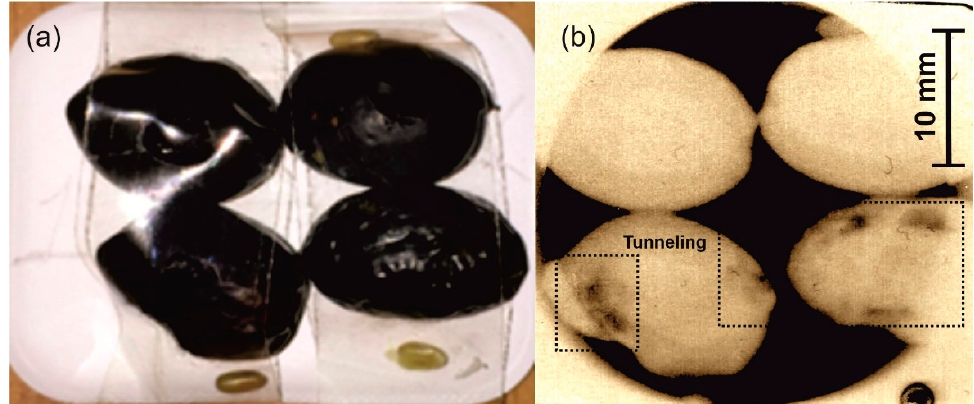
Figure 9. ( a ) A sample of olives and larvae of the olive fruit fly above the film. ( b ) X-ray image obtained from the point-projection radiography method, magnified x~1. The dashed black parallelograms indicate the affected areas.